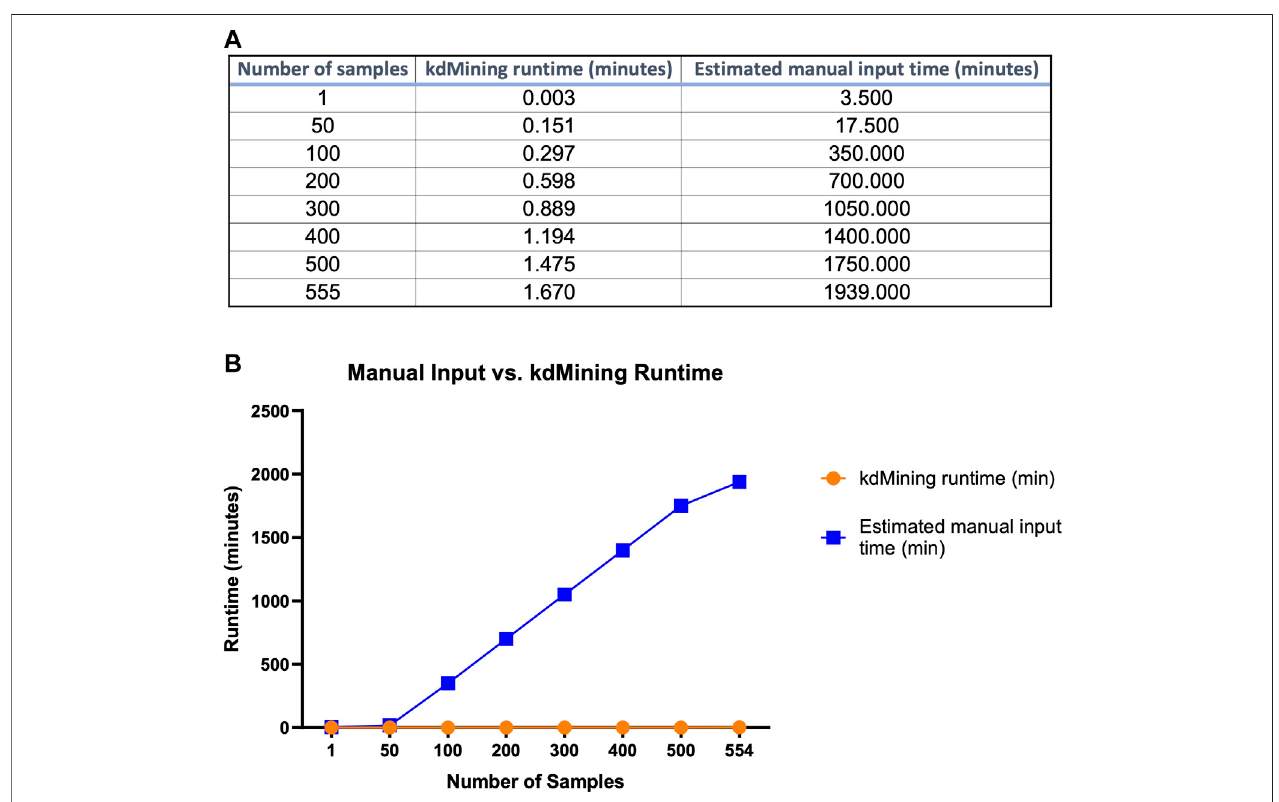
FIGURE6| Execution time comparison ofkdMining and manual approach . (A) Toprocess and analyze555 samples, kdMining takes less than1.67 min, whereas the manual approach takes more than 32.3 h. (B) Both kdMining and the manual approach have a linear runtime, but kdMining can process information at a much faster